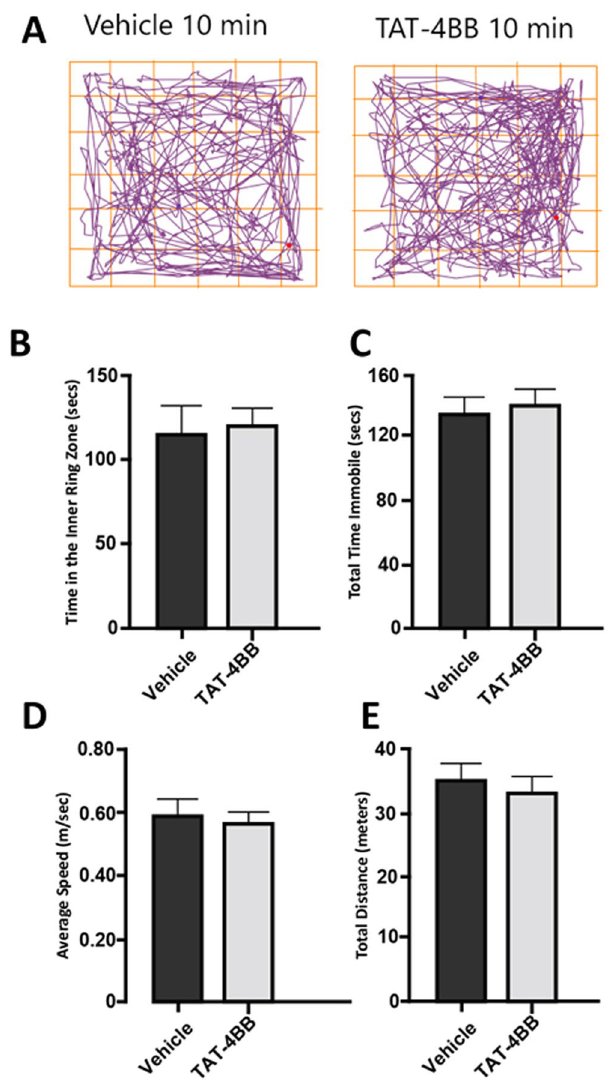
Figure 6. TAT-4BB does not produce deficits in anxiety-like behavior in female mice using open field testing (OFT). ( A ) Representative activity traces for rodents in the OFT following TAT-4BB administration. ( B ) Total time spent in the inner ring zone. ( C ) Total time immobile ( D ) Average speed ( E ) Total distance traveled. Data in both vehicle (n = 5) and decoy peptide (n = 8) reflects means and